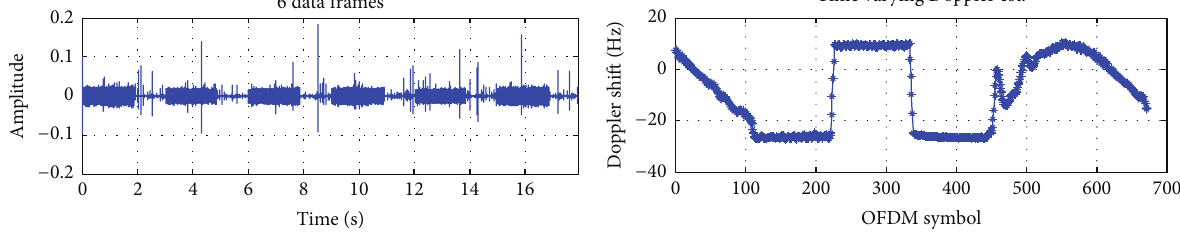
Figure 14: 64QAM, Doppler estimation at the experiment.